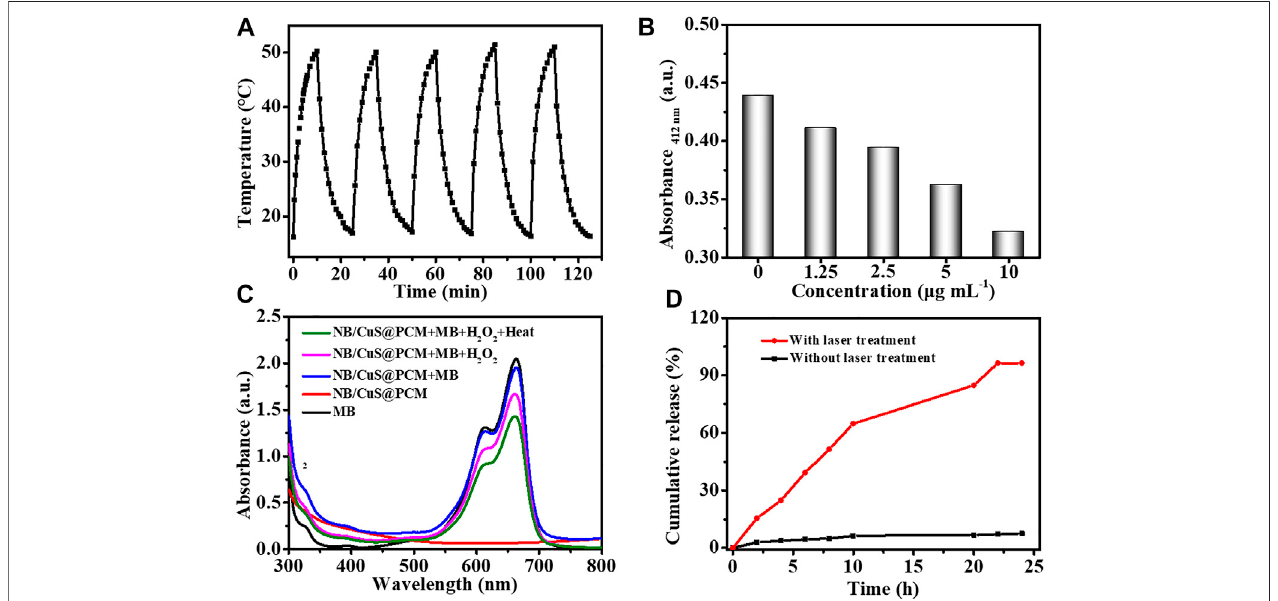
FIGURE 2 | (A) Photothermal stability assay of NB/CuS@PCM NPs. (B) GSH-depleting performance ofNB/CuS@PCM NPs. (C) Generation ability of the hydroxyl radical under different conditions. (D) NB release behavior under different conditions.